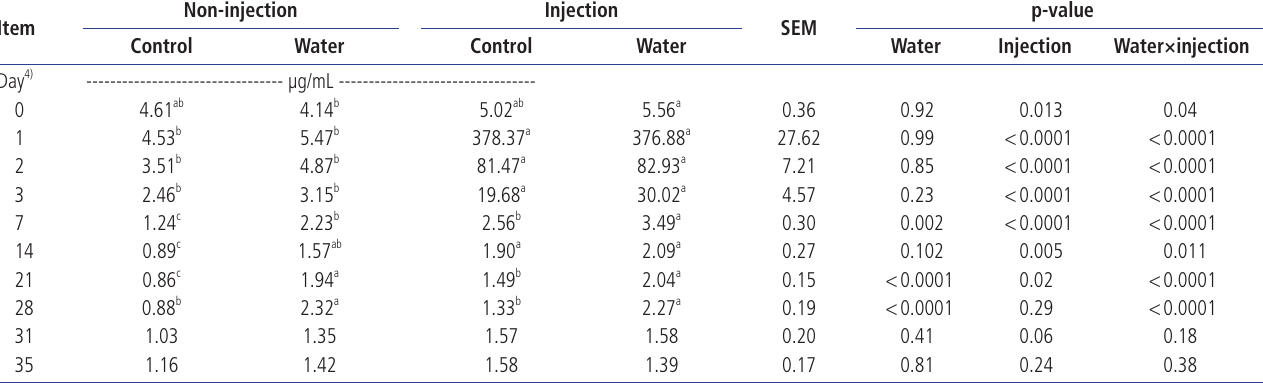
and E administration in drinking water with or without vitamin A, D 3